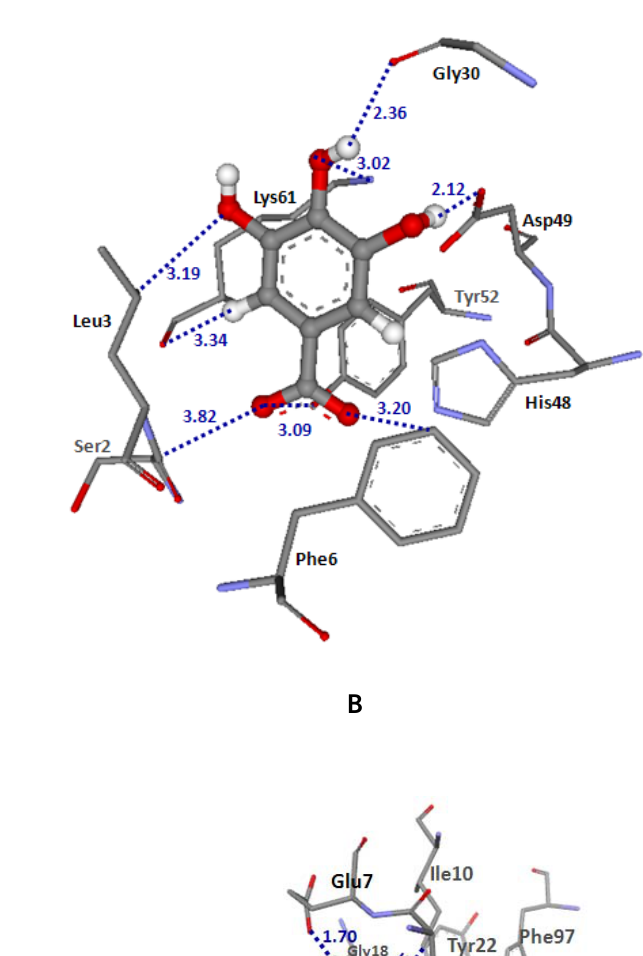
-CR structure (GA: Red, 2 -CR 2